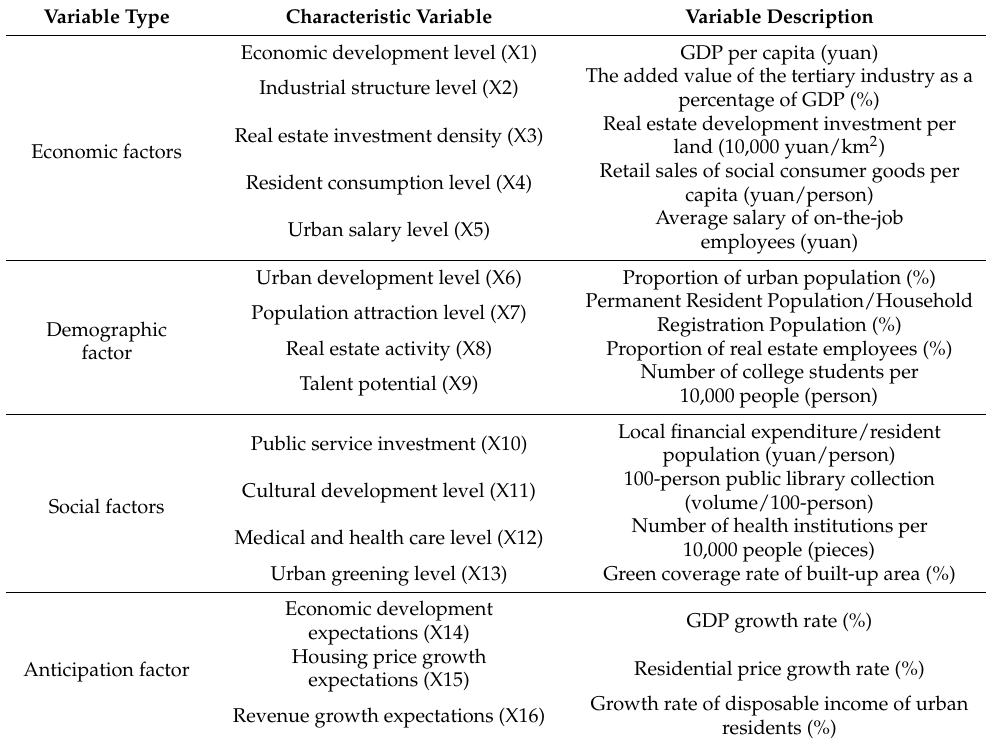
Table 4. Influencing factors of spatial differentiation of PIR in China.